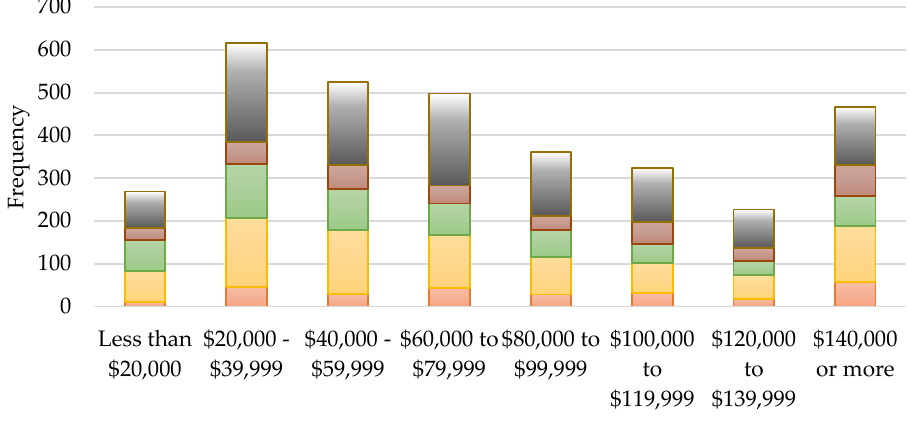
Figure 5. Household respondents’ highest earned degree per climate zone (total n = 3288).